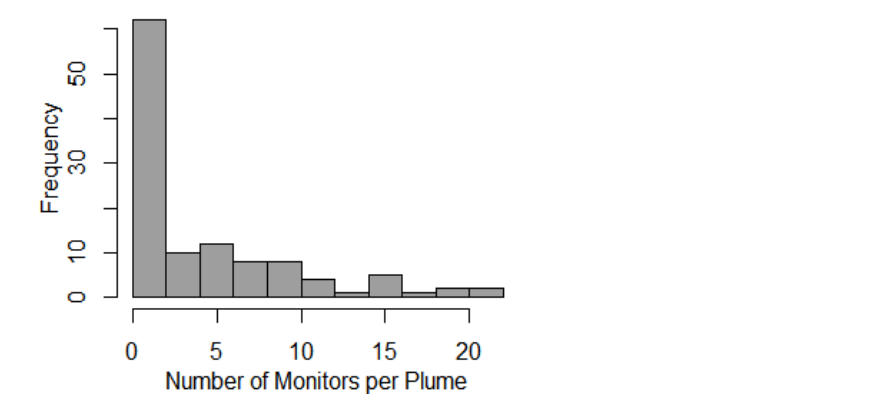
Figure 3. Histogram of the number of monitors each plume passed over (excluding those over no monitor).